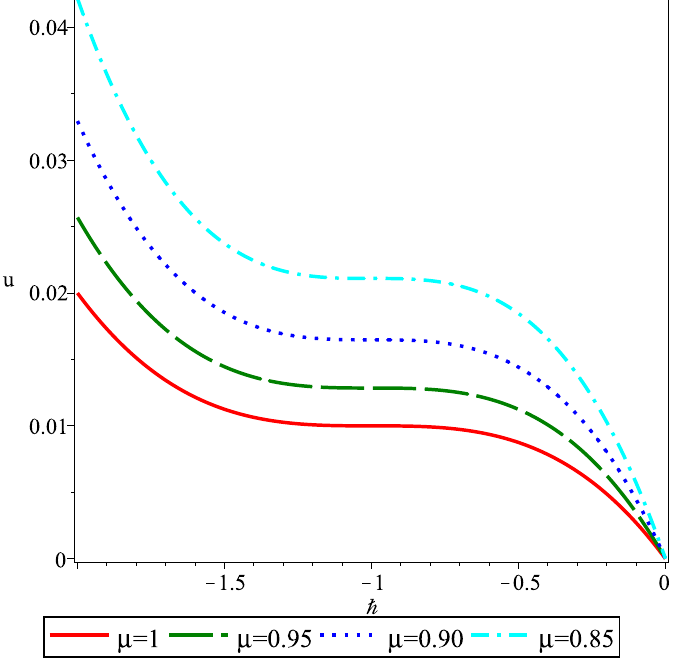
Figure 9. (cid:125)(cid:125)(cid:125) -curve of u ( t ) at t = 0.01 for various values of µ